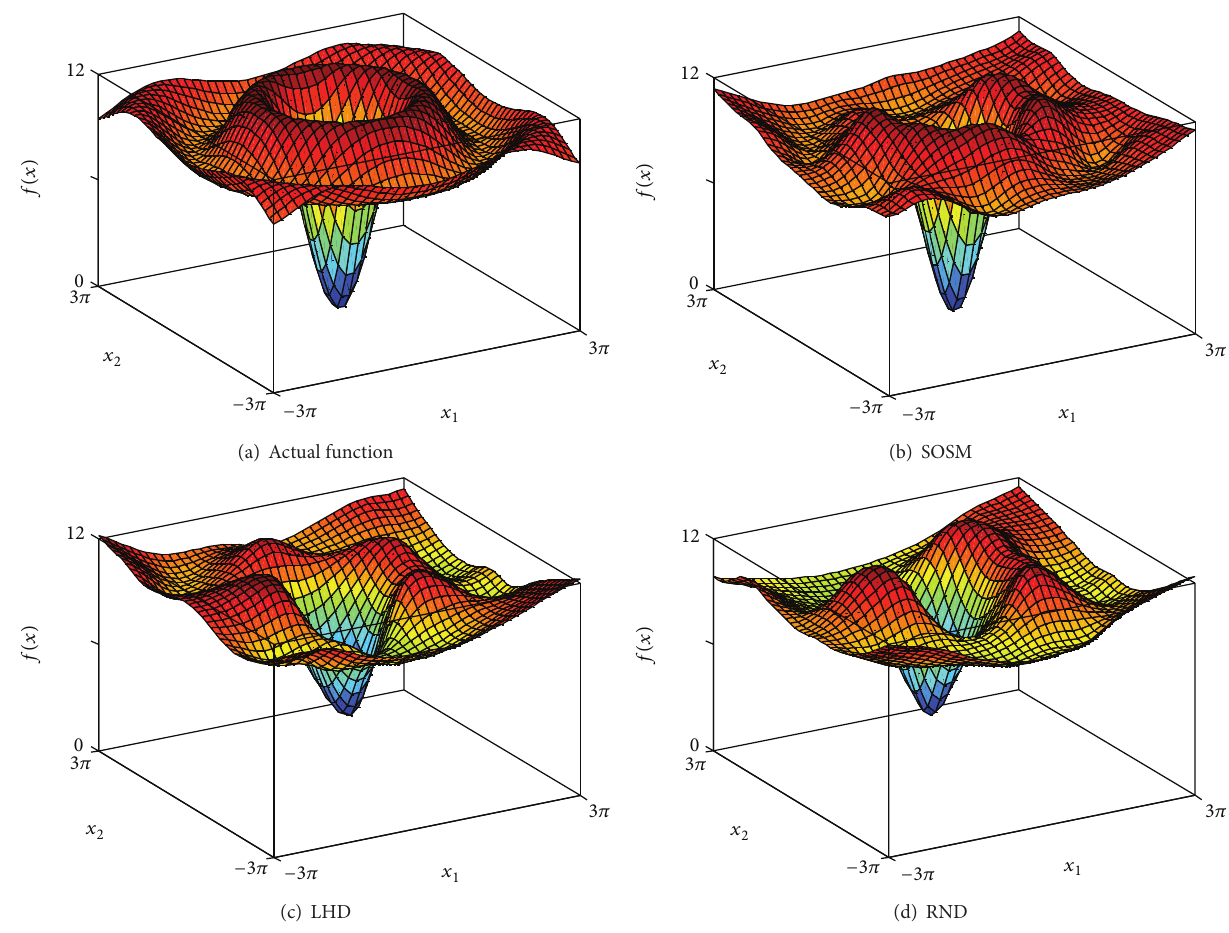
Figure 16: Function 6: actual and metamodel surface.